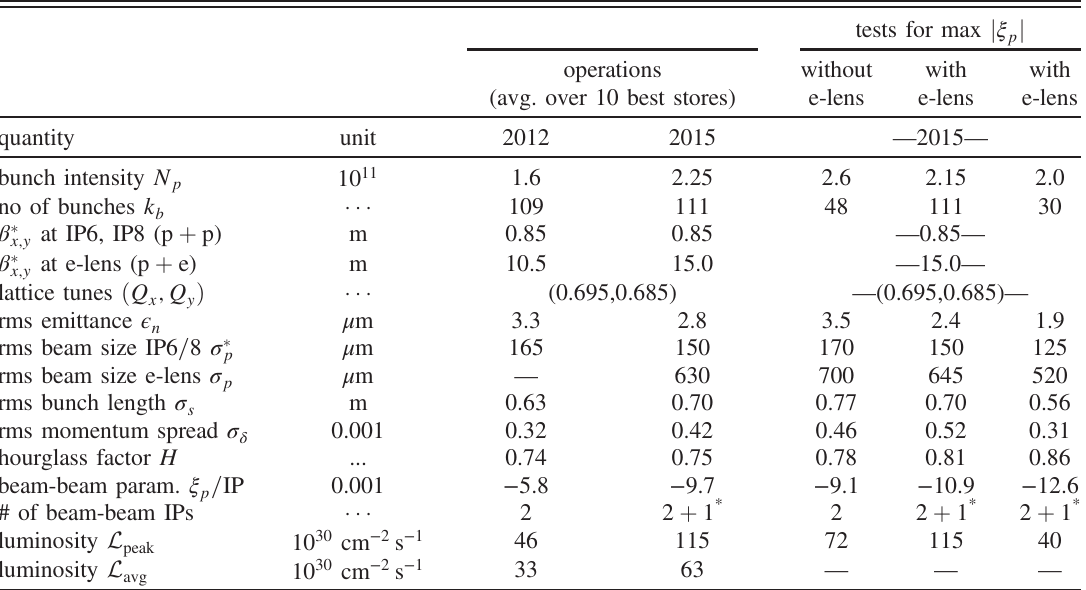
TABLE II. Main parameters for polarized proton operation at 100 GeV beam energy in 2012 (without) and 2015 (with head-on beam-beam compensation), and conditions for the maximum beam-beam parameters achieved in operation and tests in 2015 without and with electron lenses